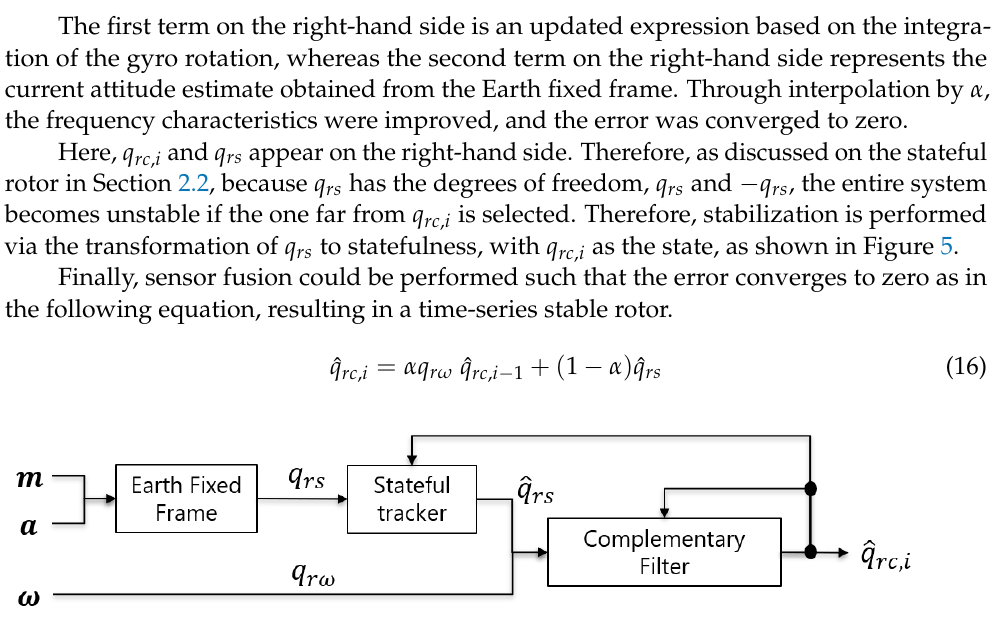
Figure 5. Block diagram of stateful complementary